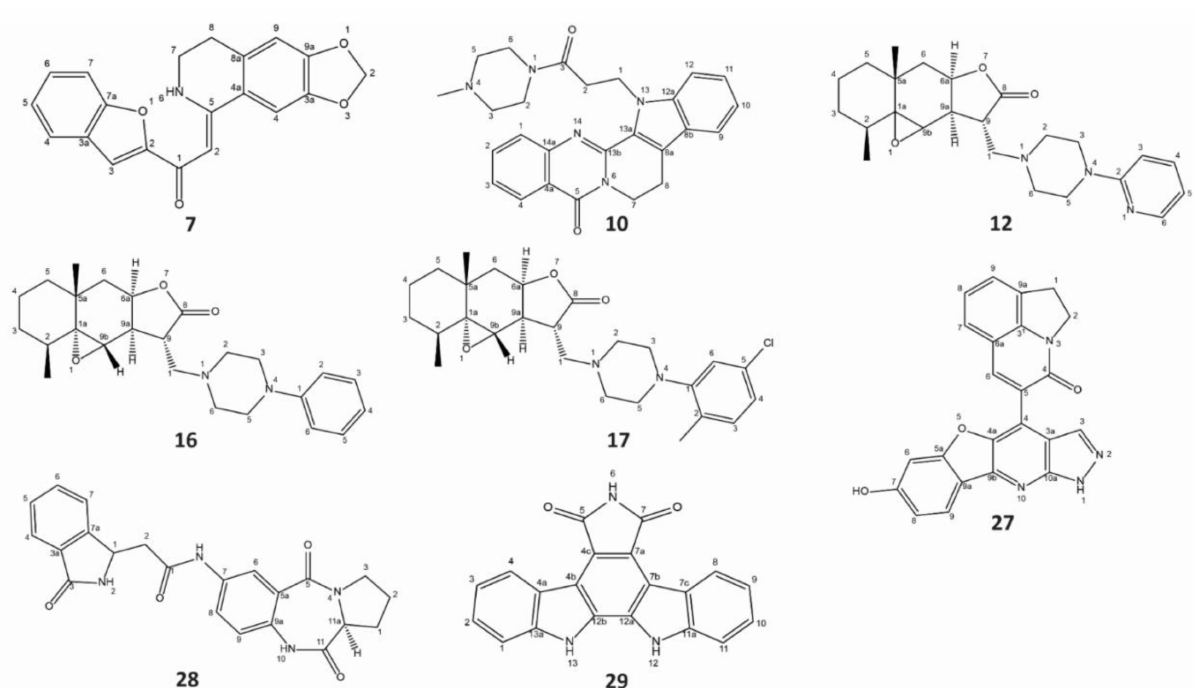
Figure 2. Structure of the eight natural compounds selected as potential glycopro- tein D inhibitors by molecular docking. All eight compounds were subjected to in vitro validation. Listed active compounds (ACs) are: